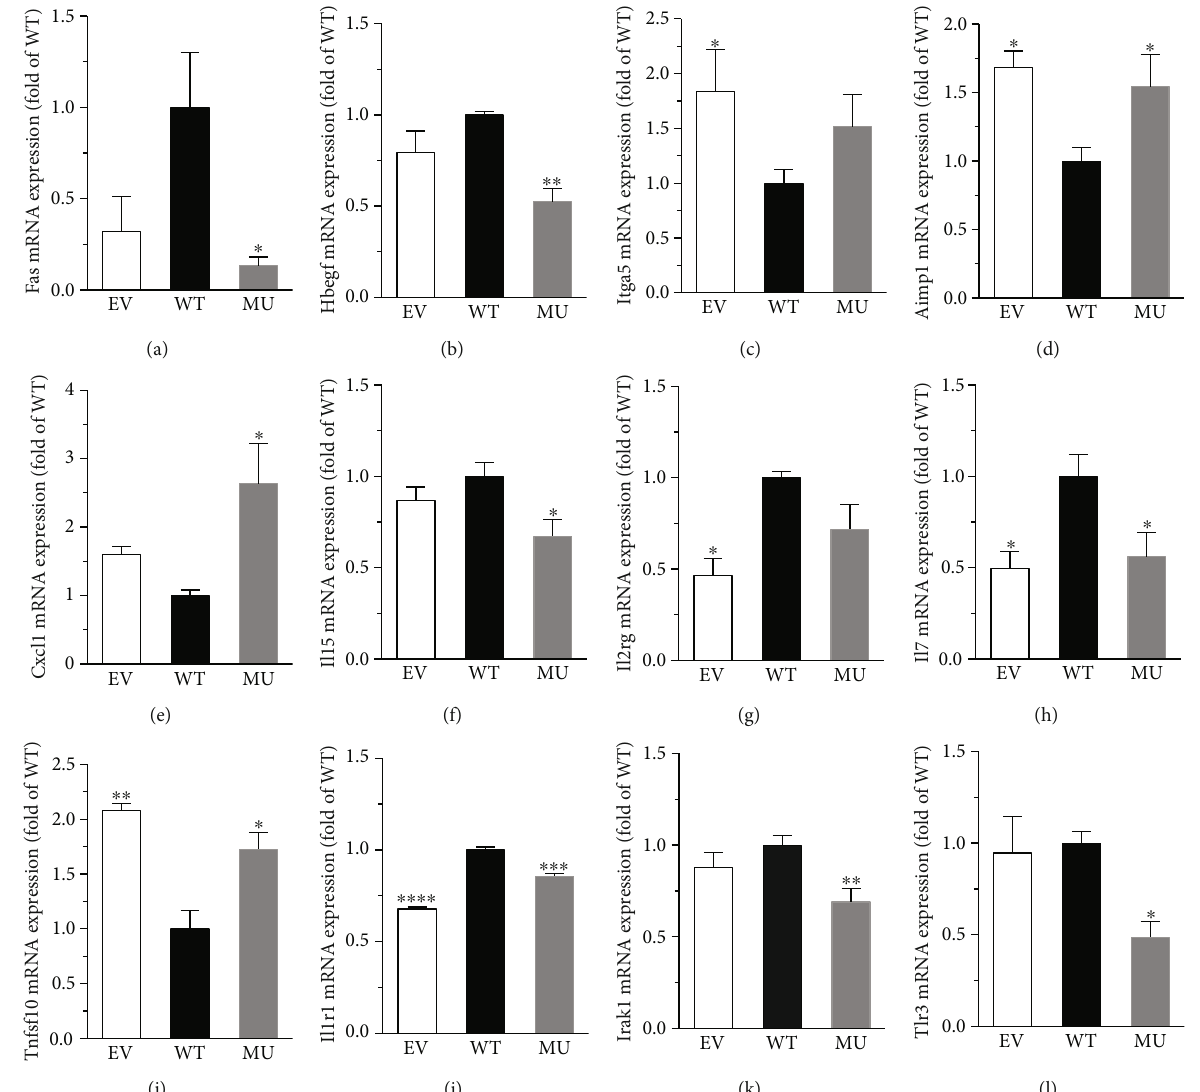
Figure 6: QRT-PCR veri fi cation of the screened DEGs. (a) Fas; (b) Hbegf; (c) Itga5; (d) Aimp1; (e) Cxcl1; (f) Il15; (g) Il2rg; (h) Il7; (i) Tnfsf10; (j) Il1r1; (k) Irak1; (l) Tlr3. One-way ANOVA, ∗ P < 0 : 05 , ∗∗ P < 0 : 01 , ∗∗∗ P < 0 : 001 , ∗∗∗∗ P < 0 : 0001 versus WT, n = 7